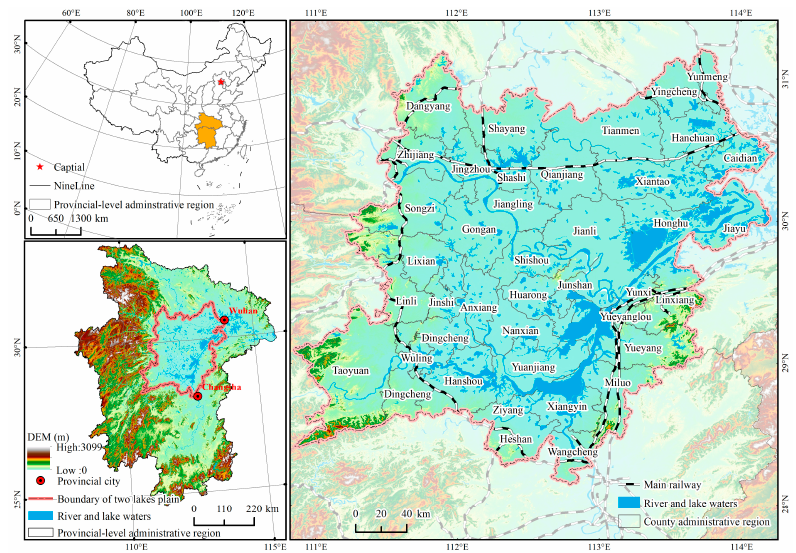
Figure 2. Topographic map of the two lake plains and distribution map of County Administrative Region.